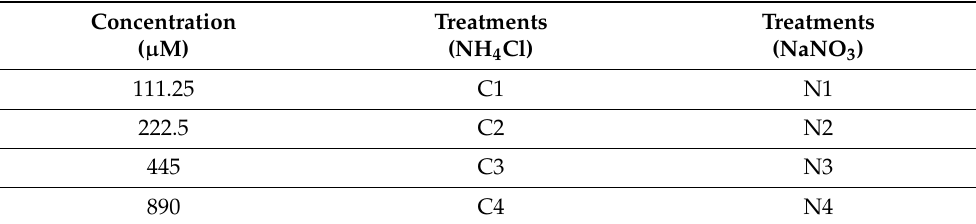
Table 1. Sources and concentrations of nitrogen used in Thalassiosira weissflogii experimental culture